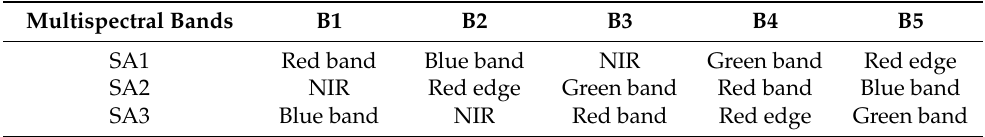
Table A1. The importance ranking of the multispectral bands. Multispectral